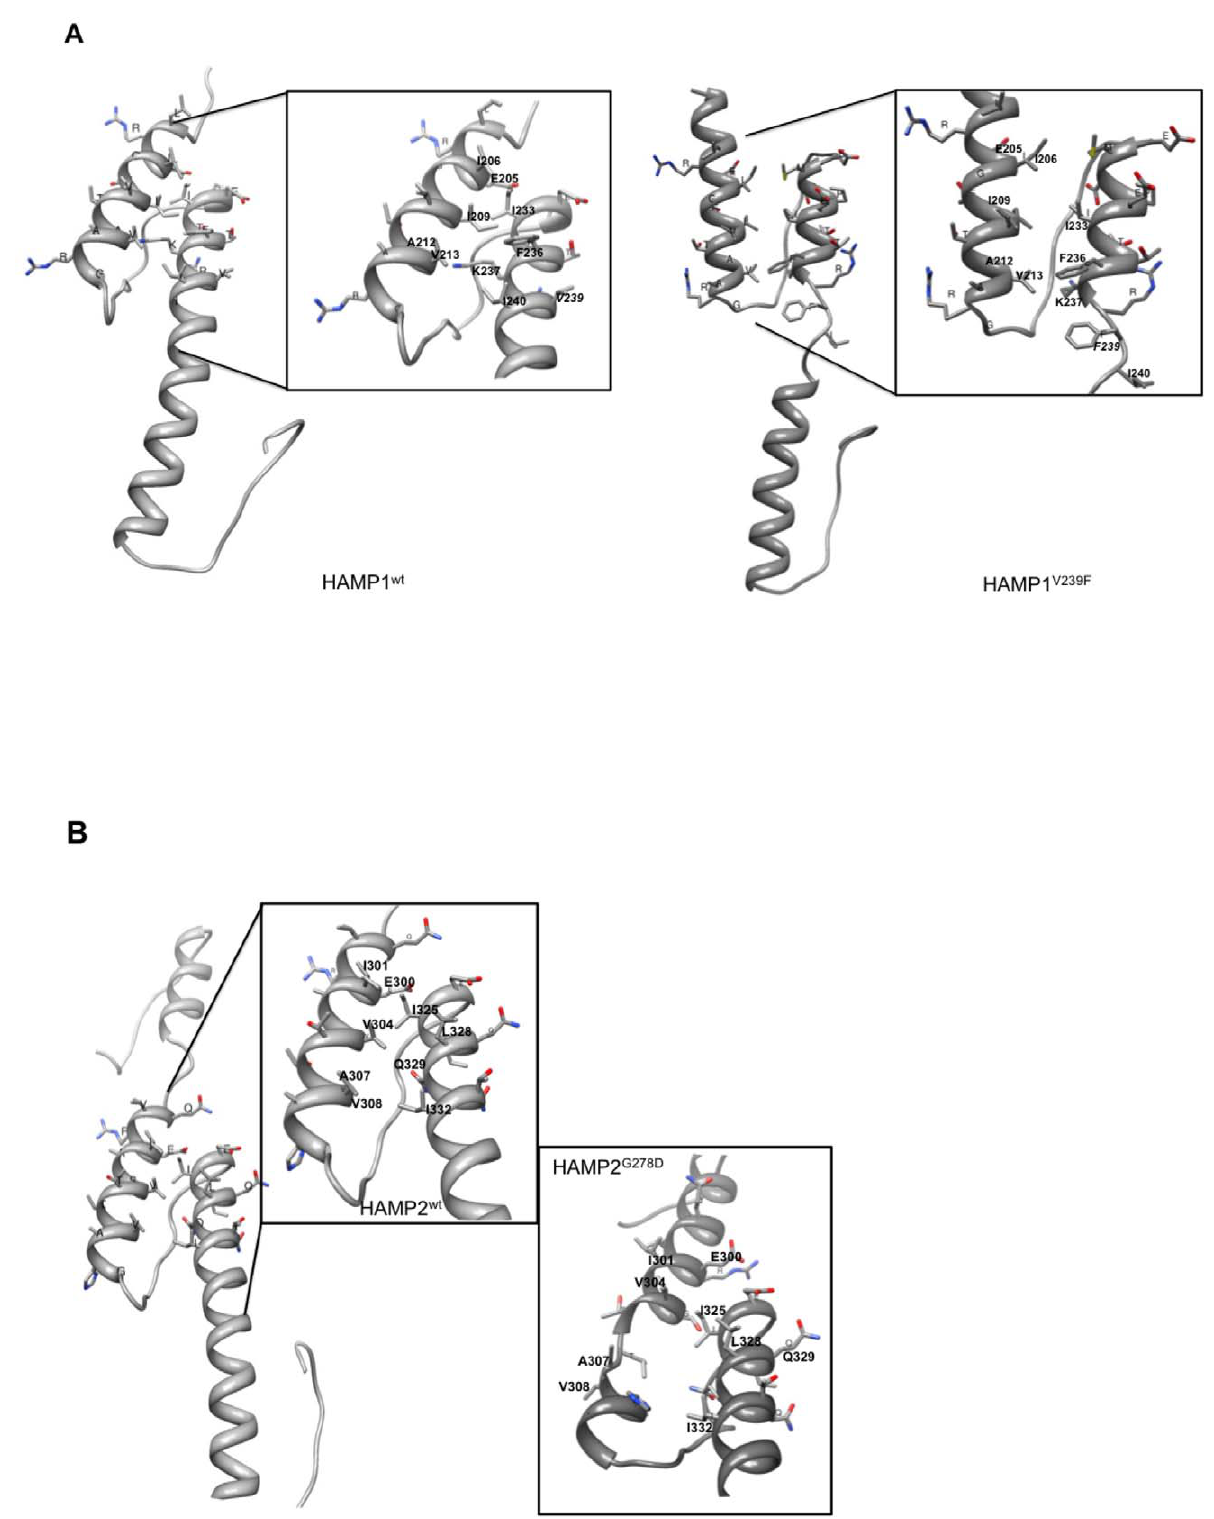
Figure 2. Homology based models of HAMP domains with focus on interactions between AS1 and AS2. A/ HAMP1 wild-type (wt) and mutant peptides. B/ HAMP2 wt and mutant peptides. The orientation of the peptides is from up (N-terminus) to down (C-terminus). Solely, the side chains from amino-acids of the connector proximal helices are displayed. Residues potentially involved in interactions are labelled; modified residues are written in italics.